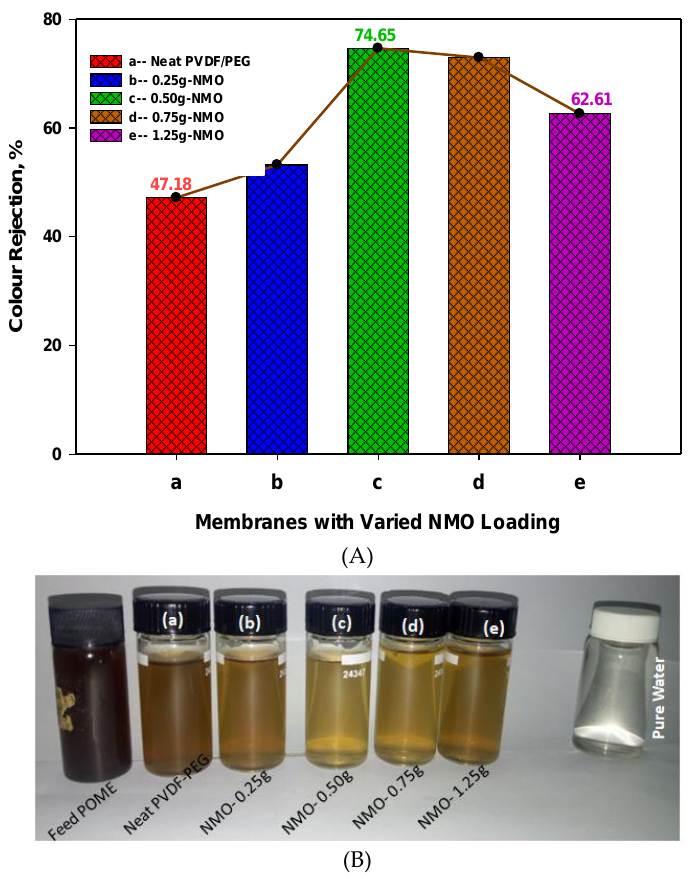
Figure 7. ( A ) Color rejection performance of neat PVDF-PEG ( a ) and modified Nano-hybrid membrane ( b – e ). ( B ). Pictorial view of color differences in the feed POME, permeate of ( a ) neat, ( b – e ) ( b – e ). ( B ). Pictorial view of color di ff erences in the feed POME, permeate of ( a ) neat, ( b – e ) modified modified membranes, and pure water. membranes, and pure water.